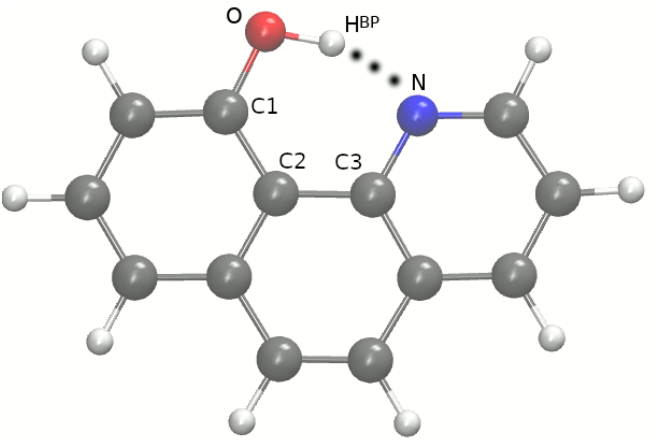
Figure 1. 10-hydroxybenzo[h]quinoline (HBQ) model for gas-phase CPMD simulation. Only atoms involved in the intramolecular hydrogen bond and quasi-ring formation are indicated. The atoms notation was prepared for the study. The dotted line indicates the presence of an intramolecular hydrogen bond. Atom coloring scheme: grey—carbon atoms, red—oxygen atom, blue—nitrogen atom, white—hydrogen atom.